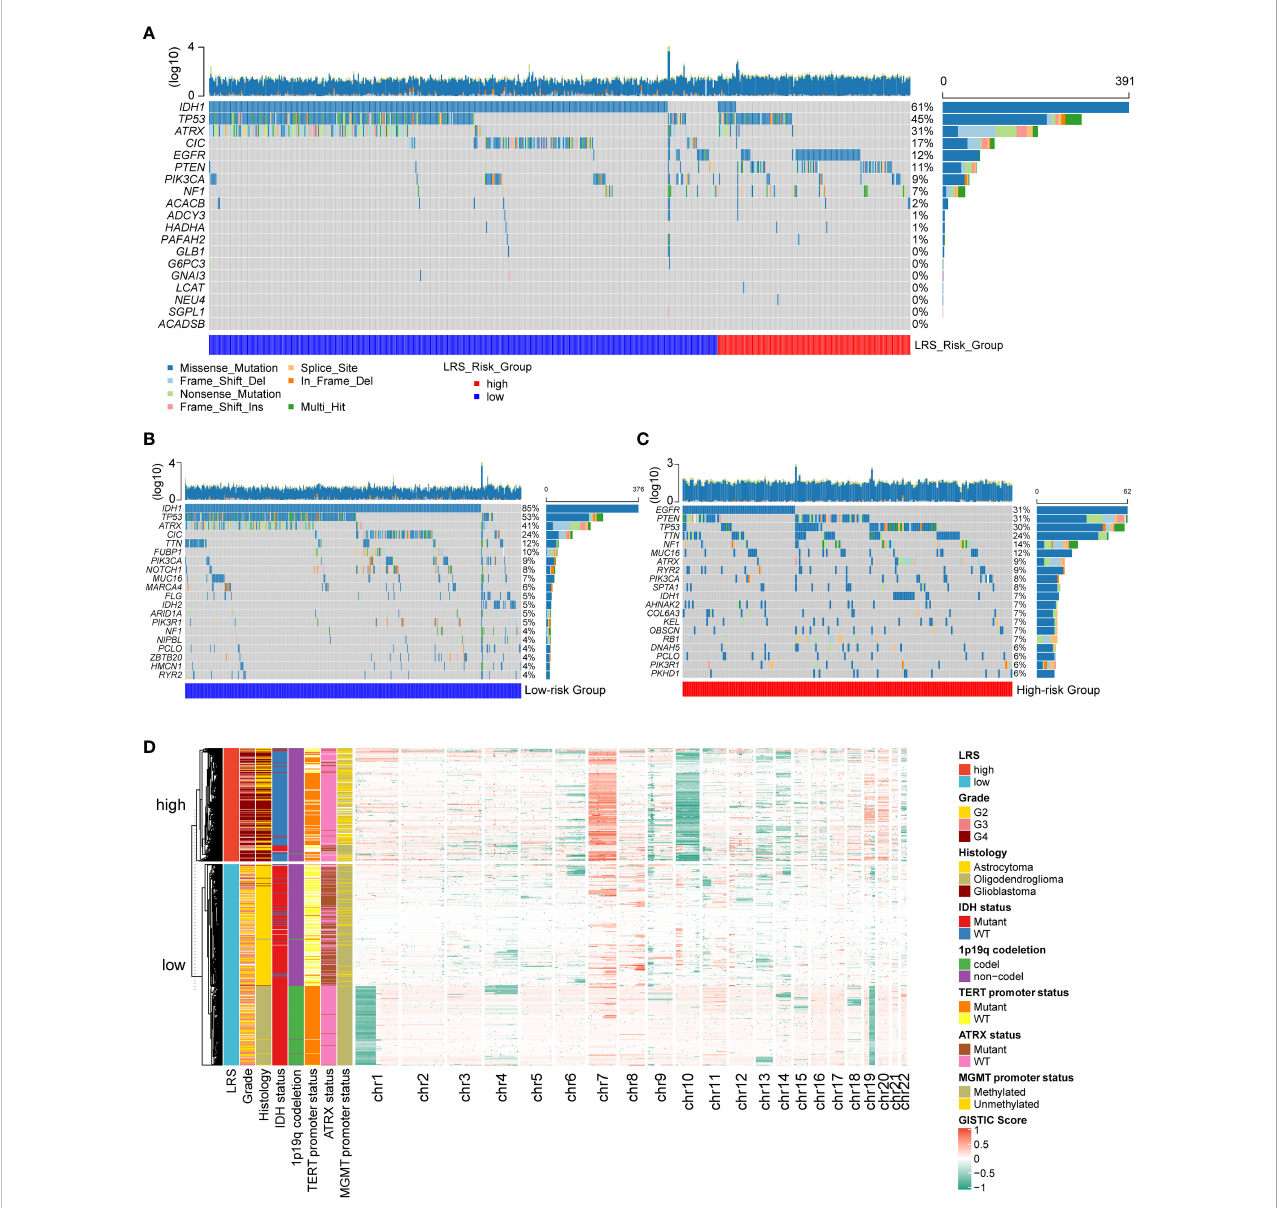
FIGURE 6 Genetic alterations of prognostic LMRGs in gliomas. (A) , somatic mutations of 11 prognostic LMRGs; Top 20 genes with highest degree of mutations in low- risk group (B) and high-risk group (C) ; (D) CNV analysis of low- and high-risk group. LMRG, lipid metabolism-related gene; CNV, copy number